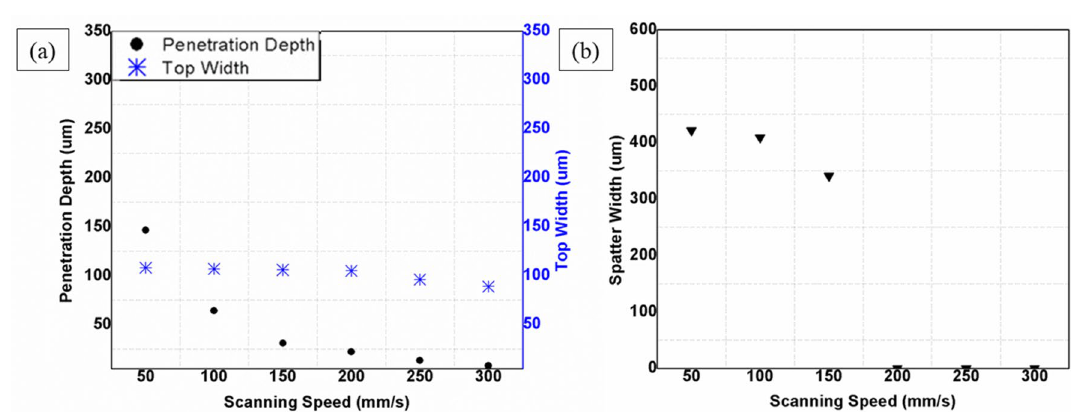
Figure 9. Effects of scanning speed; ( a ) Effect on top width and penetration depth, ( b ) Effect on spatter width [Fixed: 20 kHz, 200 ns, 20W and